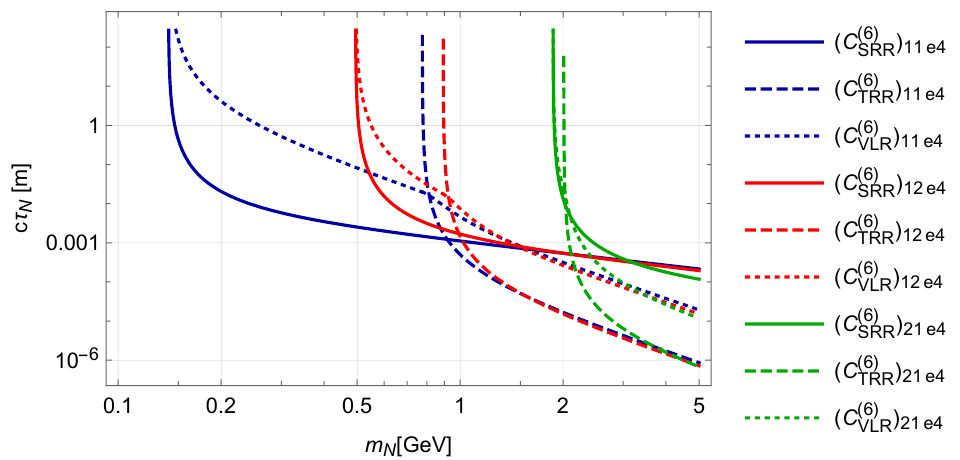
Figure 5 . Proper decay length of sterile neutrinos for various choices of EFT operators and (cid:13)avor assignments. The Wilson coe(cid:14)cients are set to unity and the minimal active-sterile mixing is turned